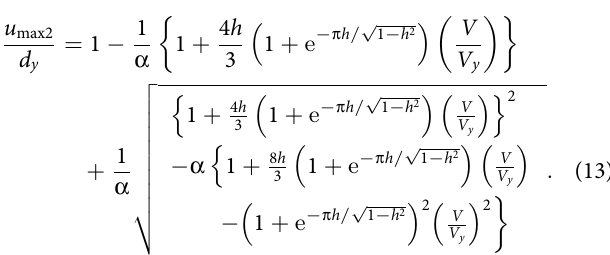
Frontiers in Built Environment |